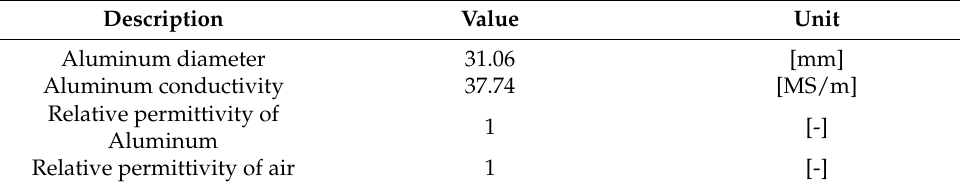
Table 3. Conductor and insulator model parameters.